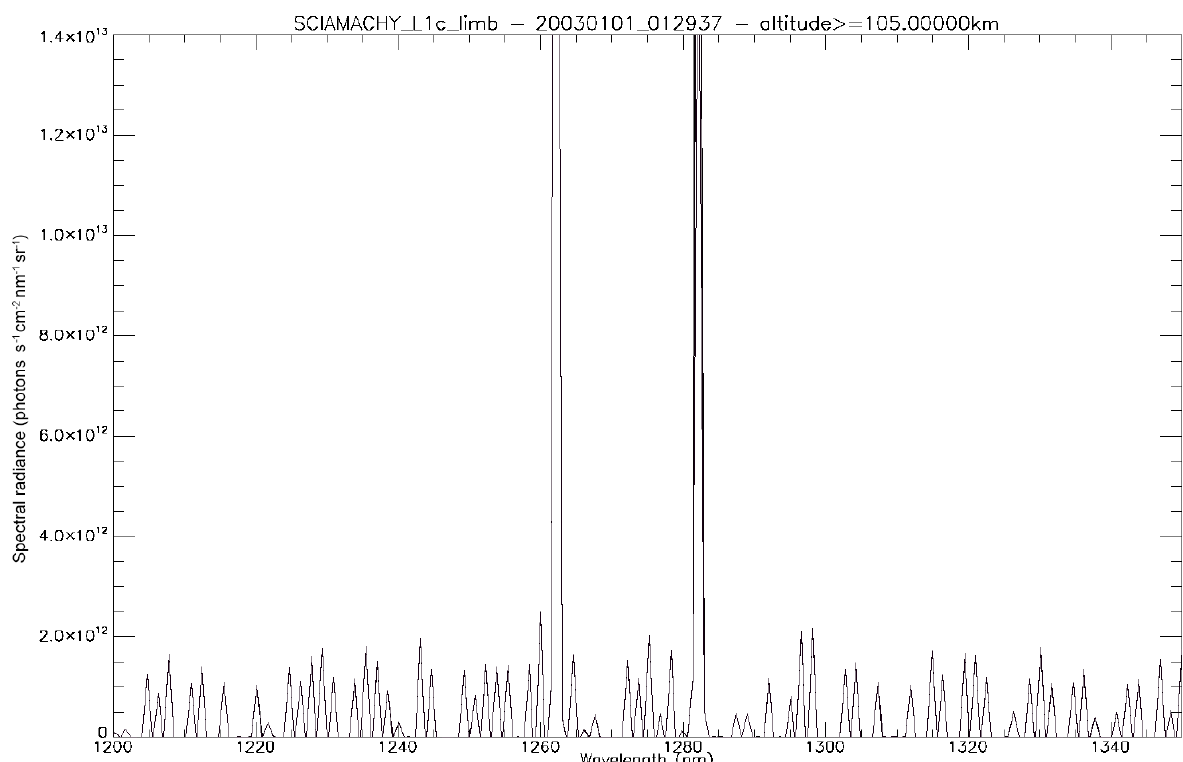
Figure F1. This high-altitude spectrum recorded above 105km contains some residual spectral (readout) patterns left from the calibration step and is subtracted from all measurements obtained at lower altitude in the same scan